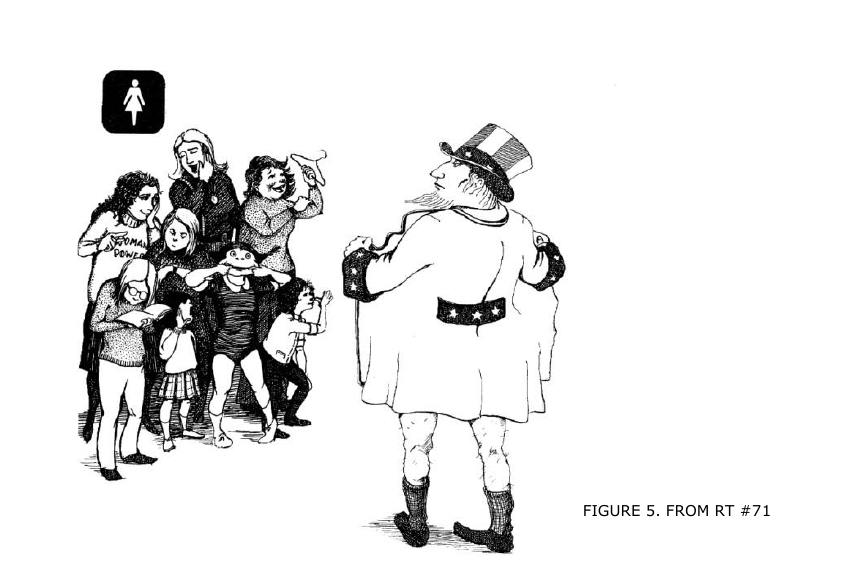
FIGURE 5. FROM RT #71